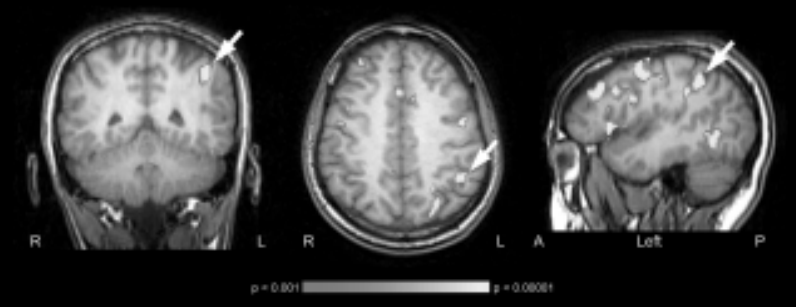
Fig. 1. Functional MRI activation maps, Activation maps are displayed in 3 planes (left to right: coronal, axial, sagittal) indicating VWM activation in the LIP lobule (white arrows) from a representative subject. Activations are displayed on high resolution T1-weighted 3-dimensional SPGR images.